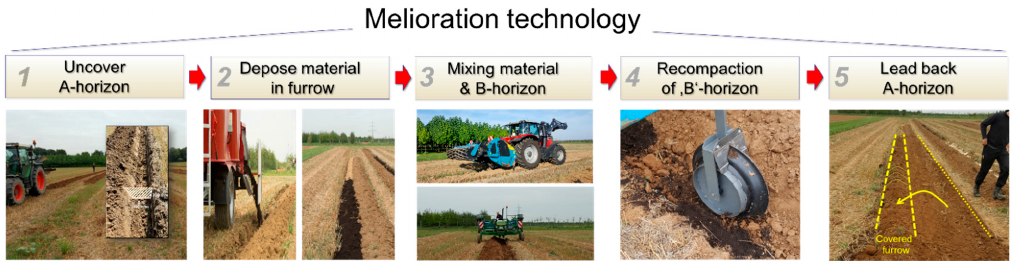
Figure 2. Phases of the Soil 3 melioration process and selected photos of the technology from the preliminary tests for tool selection and design.